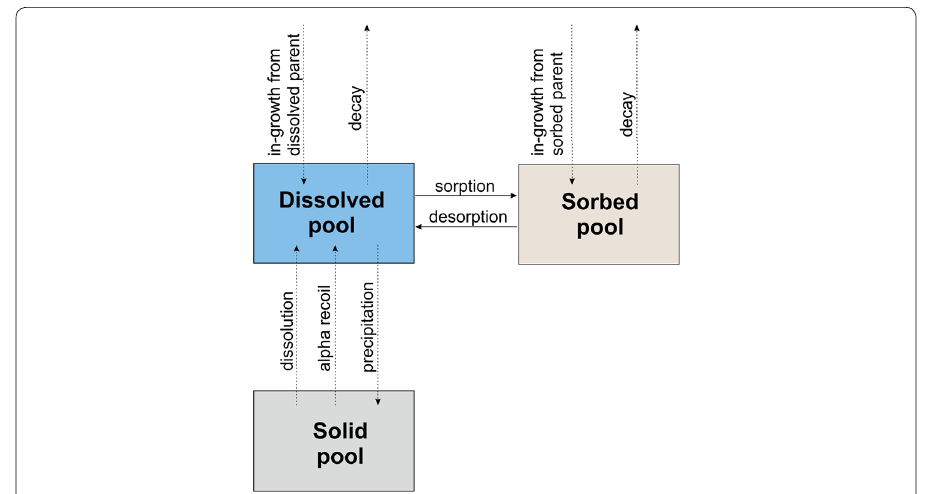
Fig. 5 Schematic representation of the water–rock interaction model suggested by Ku et al. (1992). Reversible and irreversible processes are indicated by arrows with solid and dashed lines. The figure was designed based on Ku et al. (1998)